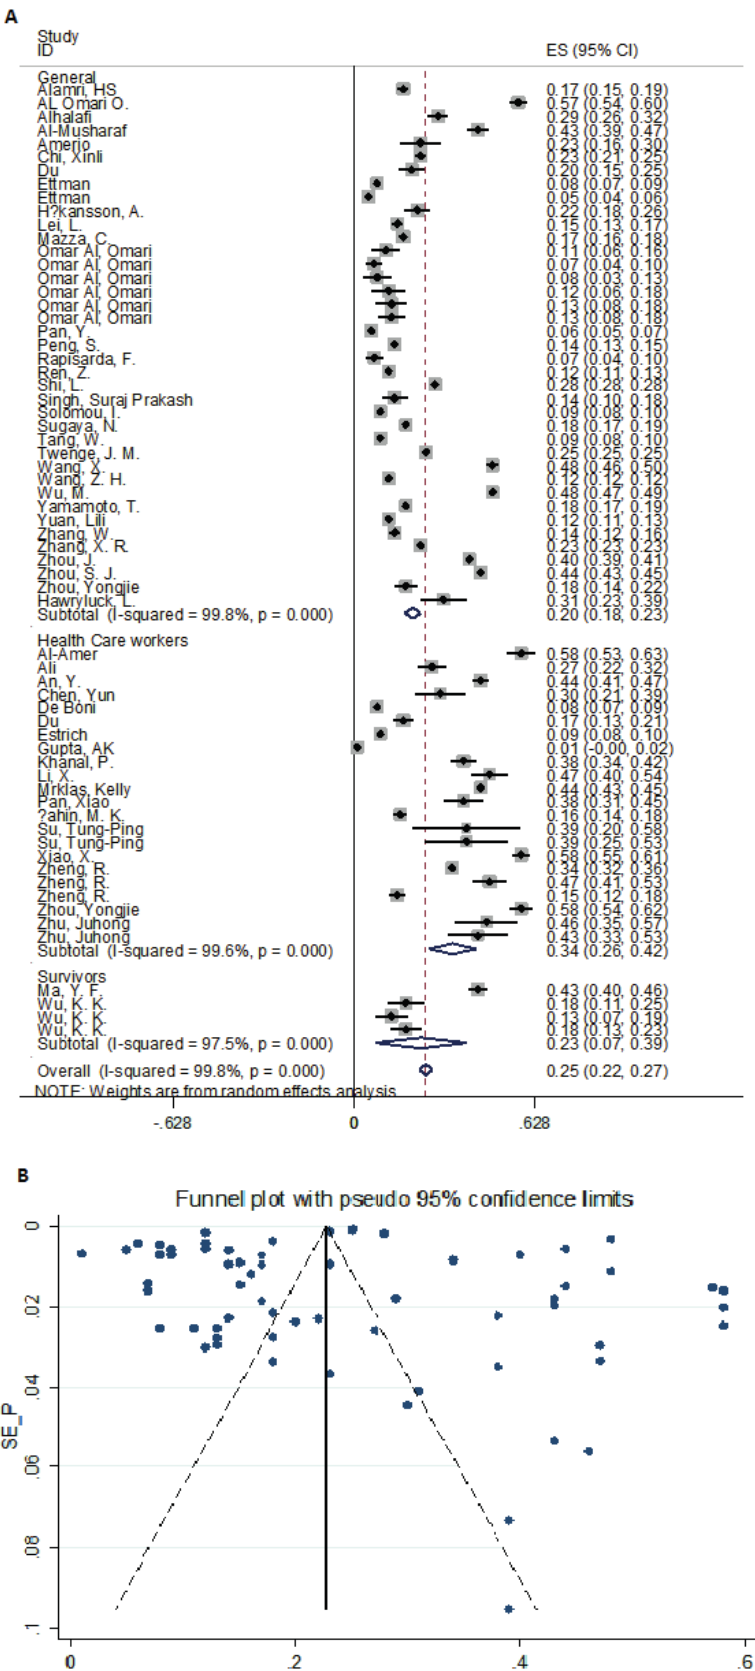
Figure-3 A: Forest plot; pooled estimate prevalence of depression during coronavirus epidemics sub-grouped by the study population. B: Funnel plot; no publication bias detected in reporting depression during coronavirus epidemics (Egger’s test P-value =